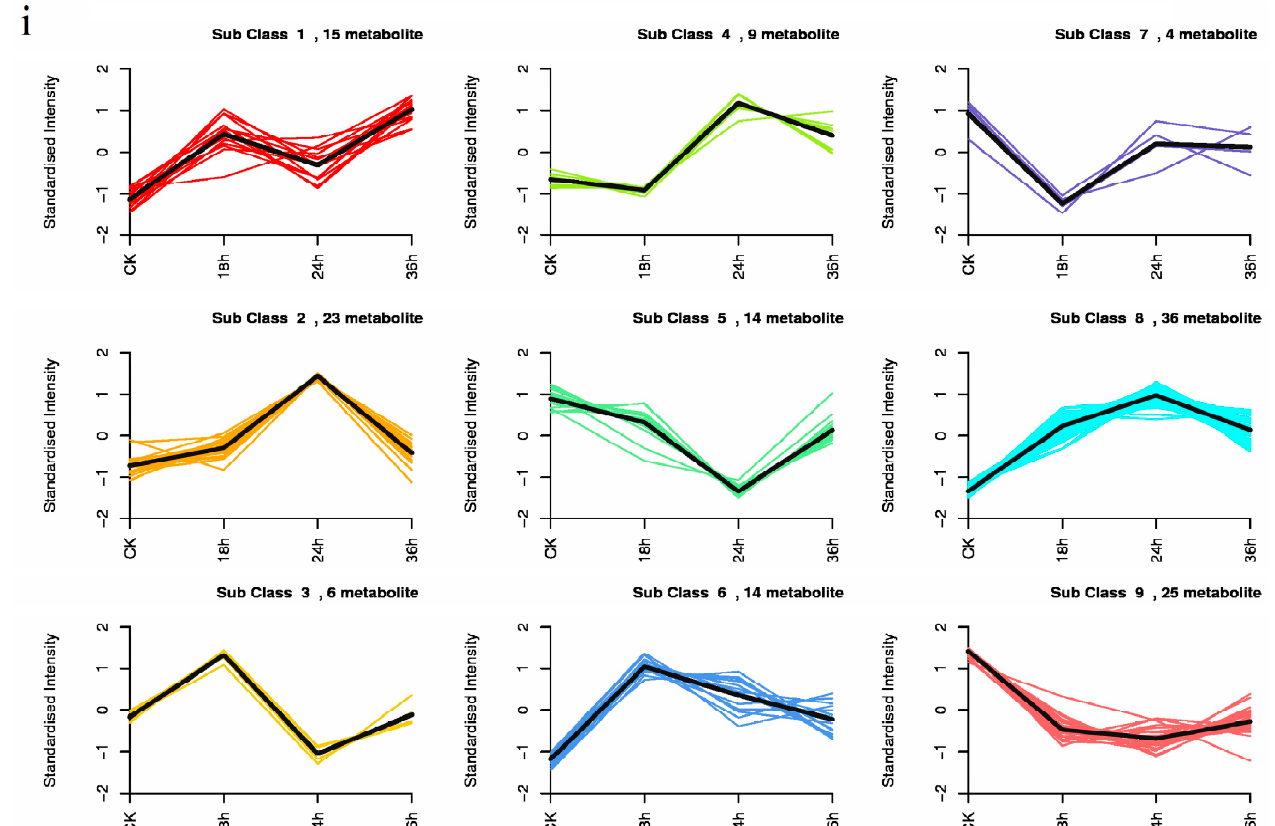
Figure 4. Differential metabolite analysis of Jerusalem artichokes under drought conditions. Volcano maps of differential metabolites in different pairwise comparisons: ( a ) 0 vs. 18 h; ( b ) 18 vs. 24 h; ( c ) 24 vs. 36 h; ( d ) 0 vs. 24 h; ( e ) 0 vs. 36 h; ( f ) 18 vs. 36 h. ( g ) Venn diagram of differential metabolites in a multiple pairwise comparison of 0 vs. 18 h, 18 vs. 24 h, and 24 vs. 36 h. ( h ) Venn diagram of differential metabolites in multiple pairwise comparisons of 0 vs. 18 h, 0 vs. 24 h and 0 vs. 36 h. ( i ) Trend analysis of differential metabolites during the treatment of drought stress from 0 to 36